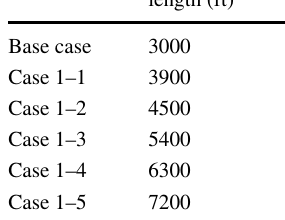
Table 8 Scenarios for lateral length sensitivity run